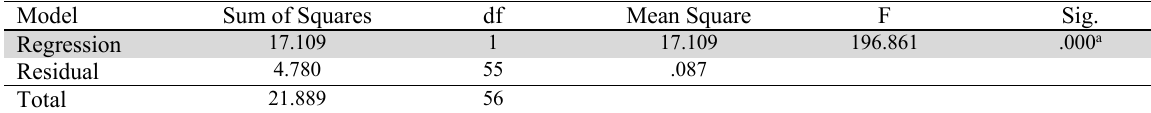
The results of the ANOVA test